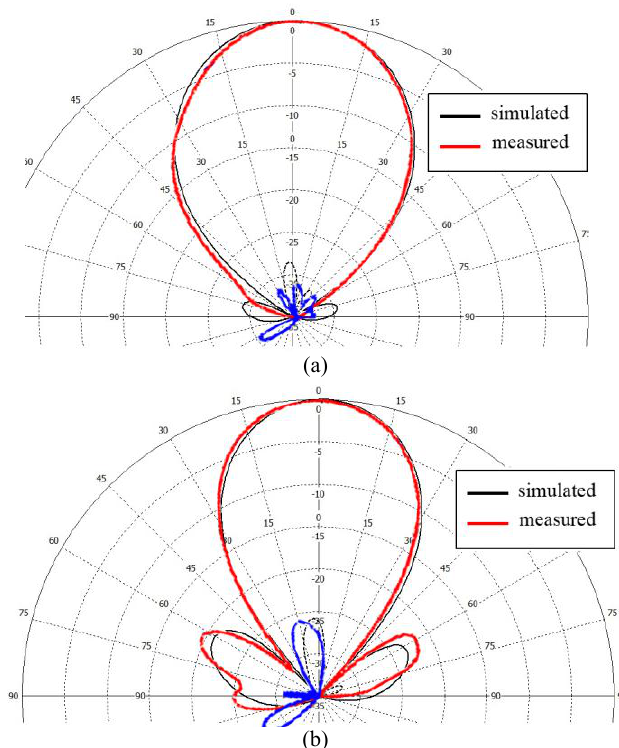
Fig. 3. Normalized radiation pattern at horizontal plane (a) f=1.71GHz, (b) f=2.17GHz.